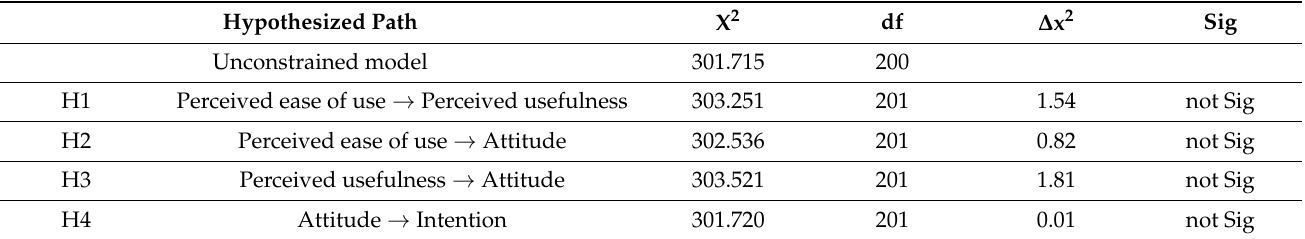
Table 7. Hypothesis path constraints